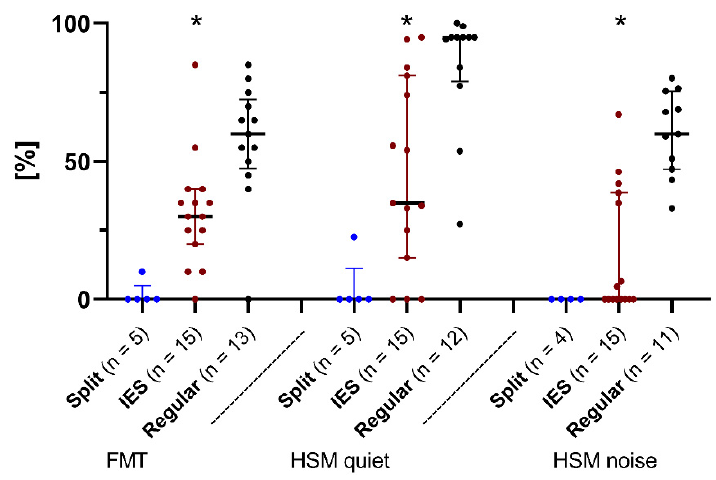
Figure 5. The Freiburg monosyllabic word test (FMT), and the HSM sentence test in quiet and in noise. Median scores (in % correct) after 6 months of device use. Comparing patients from the IES group (red dots), the REGULAR group (black dots), and the SPLIT group (blue dots). Asterisks mark significant differences between groups.